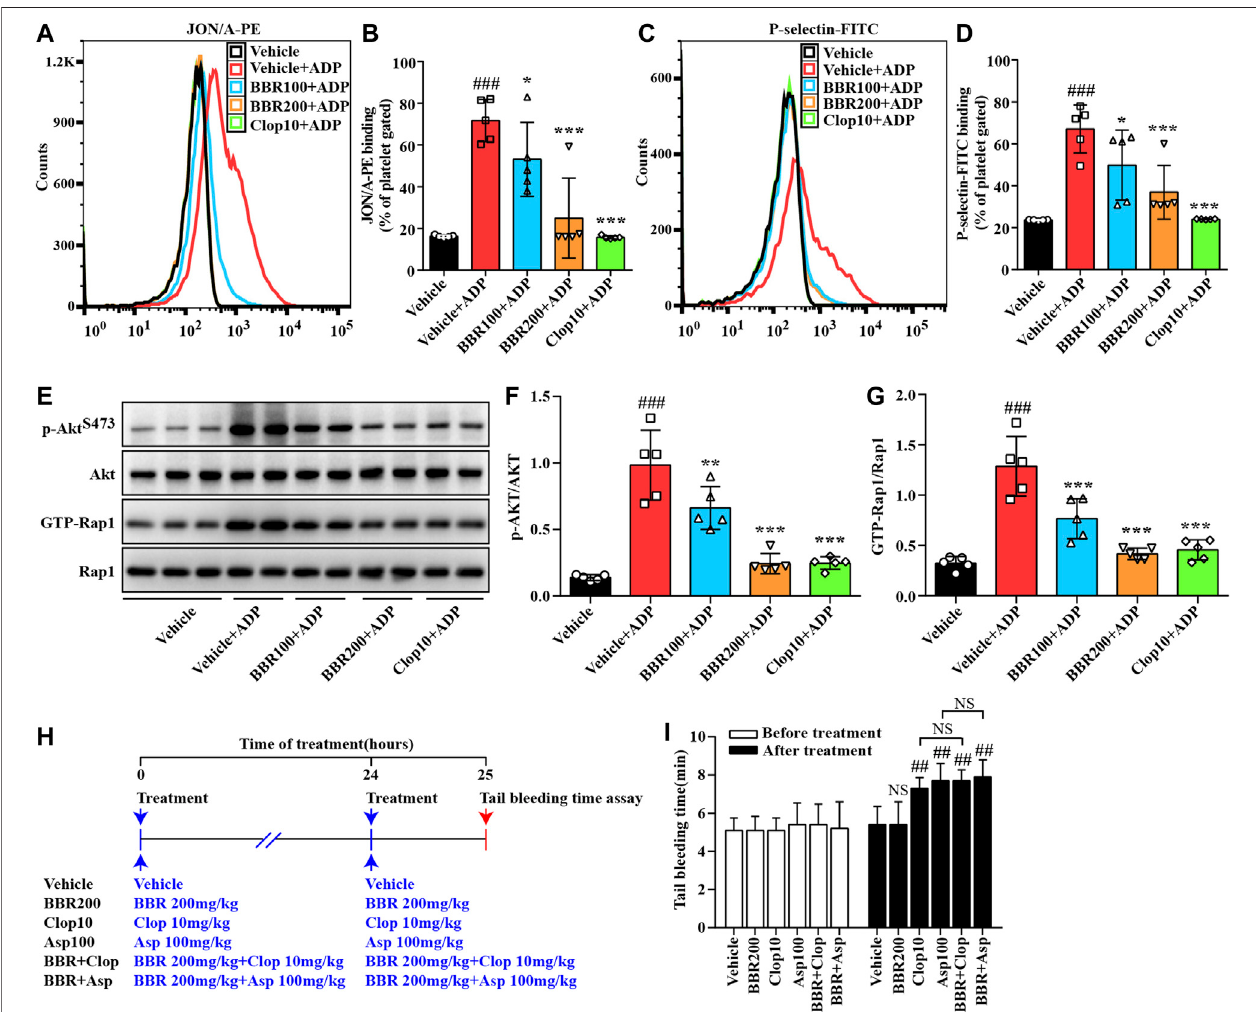
FIGURE 8 | Effects of BBR on platelet activation ex vivo and the tail bleeding time in mice. Twenty- fi ve C57BL/6N mice were divided into fi ve groups, and each group received the treatment as indicated. The WPs were prepared and treated with the vehicle control (0.1% DMSO) or ADP for 10 min, and the percent of JON/ A-PE – positive platelets (A-B) and P-selectin-FITC – positive platelets (C-D) were determined by fl ow cytometry. Proteins were extracted for pull-down and Western blot analysis of p-Akt S473 and GTP-Rap1 levels (E-G) , which were normalized to Akt and Rap1, respectively, and plotted as indicated. Representative images of fl ow cytometry (A,C) andproteinblots (E) areshown.Forquantitativedata (B,D,F,G) ,valuesareexpressedasmean ± SDof fi vemiceineachgroup.Statisticallysigni fi cant differencescomparedwiththevehiclecontrolgroupareindicatedby ### p < 0.001,andstatisticallysigni fi cantdifferencescomparedwiththevehiclecontrol+ADPgroup are indicated by * p < 0.05, ** p < 0.01, and *** p < 0.001. In a parallel experiment, 30 mice were divided into six groups and treated as indicated (H) . Before and after the treatment,thetailbleedingtimewasdetermined (I) .Valuesareexpressedasmean ± SDof fi vemiceineachgroup,andstatisticallysigni fi cantdifferencescomparedwith the vehicle control group are indicated by ## p <